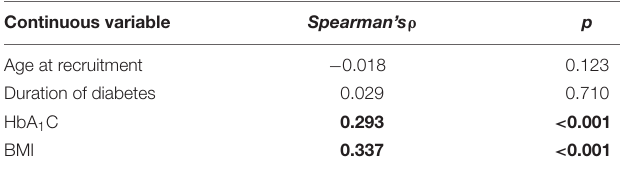
TABLE 3 | Eating disorders diagnosed according to DSM-5 criteria in the study sample.